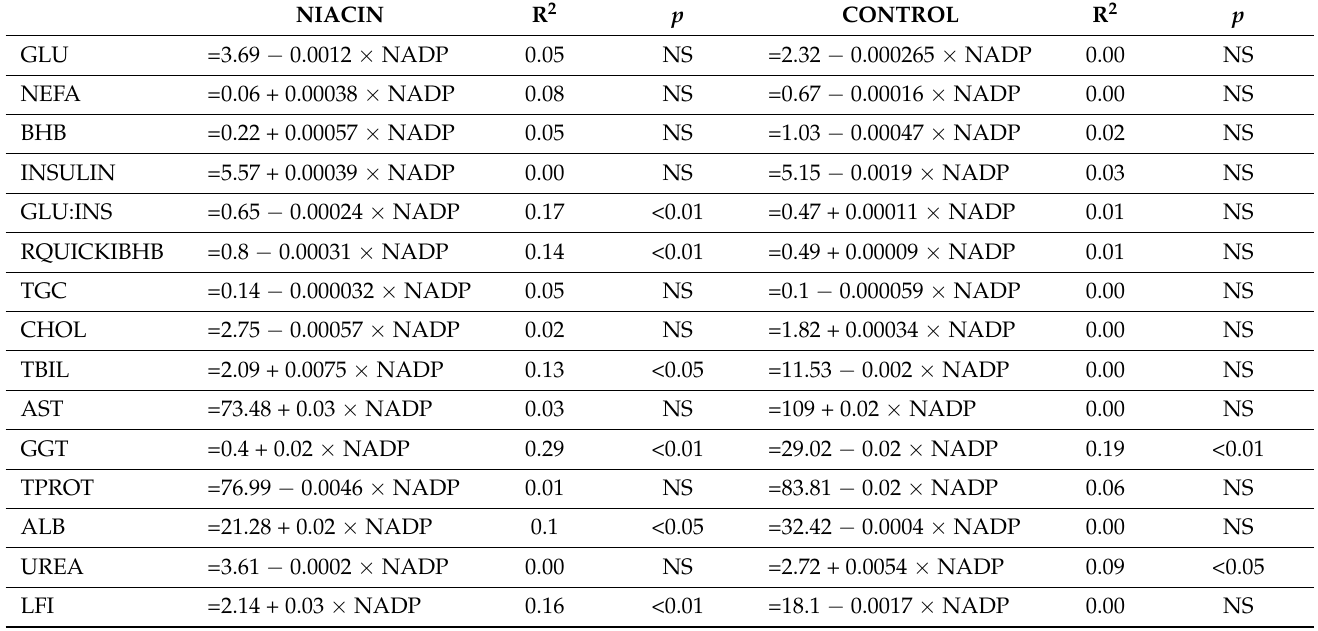
Table 3. Relationship of metabolic parameters with NADP values in cows that received and did not receive additional niacin. Abbreviations: nicotinamide adenine dinucleotide phosphate (NADP), glucose (GLU), nonesterified fatty acid (NEFA), beta-hydroxybutyrate (BHB), glucose to insulin ratio (GLU:INS), Revised Quantitative Insulin Sensitivity Check Index with BHB (RQUICKIBHB), triglycerides (TGC), cholesterol (CHOL), total bilirubin (TBIL), aspartate aminotransferase (AST),